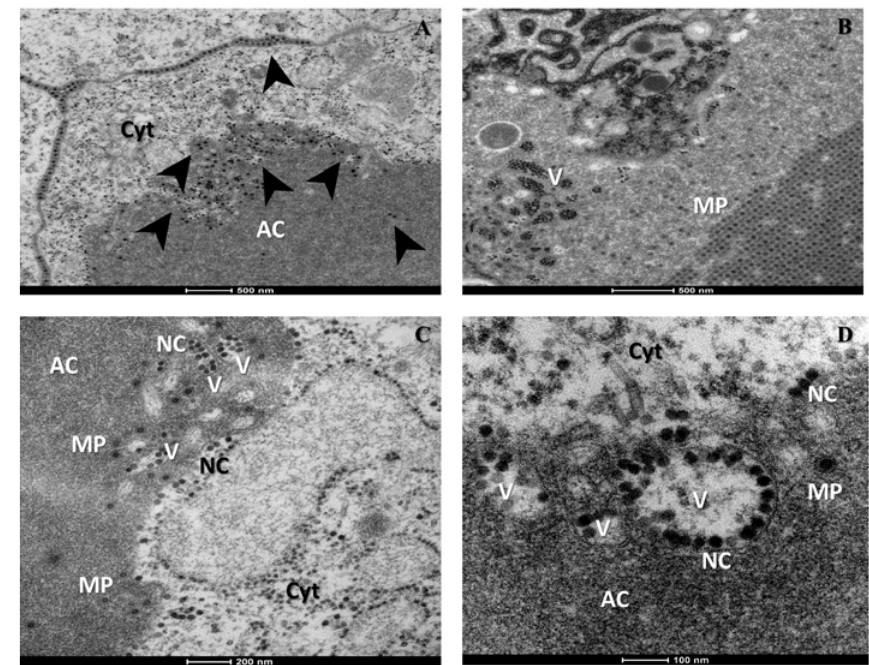
Figure 4. CHIKV entry in the apical cavities of salivary glands acinar cells of Ae. albopictus . ( A ) Overview of CHIKV in the acinar cell (black arrows); ( B , C ) detail of apical cavities (AC) where numerous vesicles (V) containing CHIKV nucleocapsids (NC) are shown. CHIKV mature particles (MP) are always observed outside the vesicles; ( D ) detail of vesicles containing CHIKV nucleocapsids in the apical cavity of the acinar cell. Cyt: cytoplasm. Images were captured using a FEI Tecnai Biotwin transmission electron microscope.